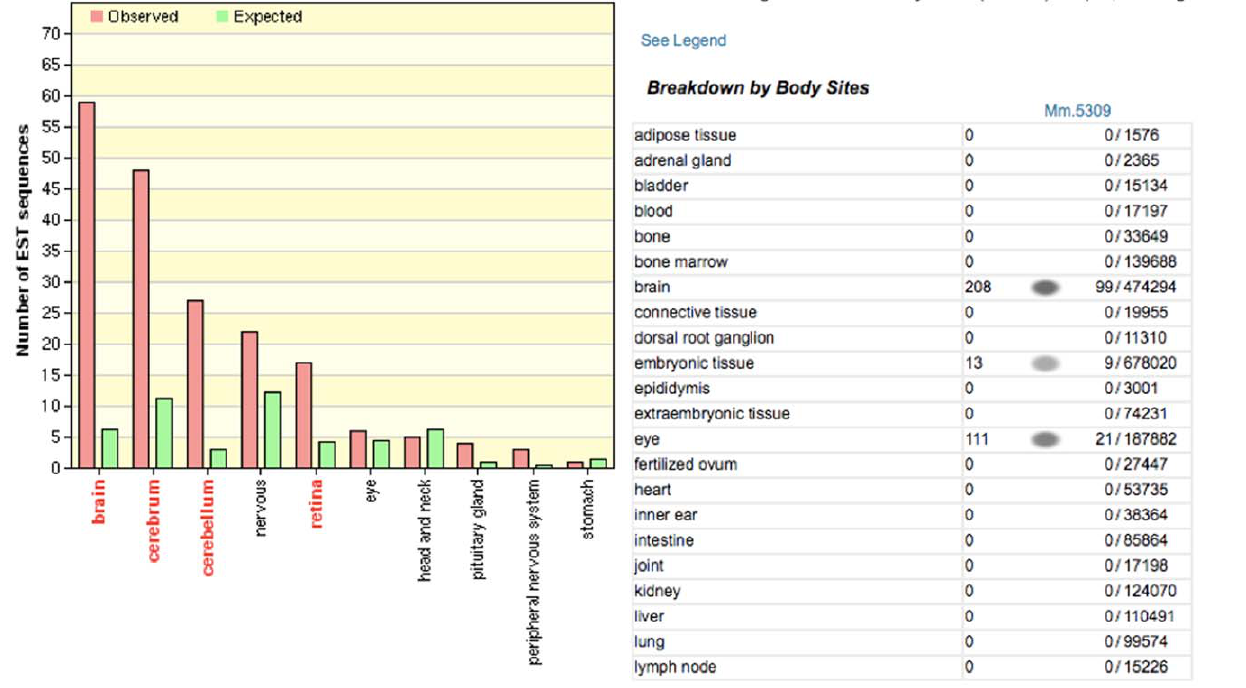
Figure 9. Tissue expression pattern and profiles for the gene Gabrg2. Left : ( a ) Tissue expression pattern for Gabrg2 (in Table 8 ) via WebGestalt. The height of the red bar represents the observed number of EST sequences for the selected gene in the tissue. The height of the green bar represents the expected number of EST sequences (Expected number of EST sequences for a specific gene in a specific tissue = Total number of EST sequences for the gene in all tissues x Total number of EST sequences for all genes in the tissue/Total number of EST sequences for all genes in all tissues). Tissue types in which the gene is significantly over-represented ( p , 0.01) are labeled red. Tissue types in which the gene is significantly under-represented ( p , 0.01) are labeled blue. Right : ( b ) Expression profile suggested by analysis of EST counts in UniGene database for the gene Gabrg2 (UniGene ID: Mm.5309); only portion (top part) of the profile is shown. The first column is for the pool name. The number on the left side of the spot column is in the unit of ‘‘Transcripts per million’’ (TPM) and the ratio on the right side of the spot column is the ratio of ‘‘EST of the query gene /Total EST in pool’’. The spot intensity is based on TPM. raw and scaled distribution metrics for that data, and annotated File S1 This file contains supplementary text and figures, lists of refined cluster (class) assignments. including supplementary methods, and figures that show the cutoffs for candidate biomarker identification. Table S3 Biomarker tables. *** Note: Refer to .xls source file *** This Excel workbook contains metric data used to identify candidate biomarkers, and a list of the identified biomarkers for each tissue analyzed, including brain, lung, liver, embryo, heart, and small intestine. XLS)